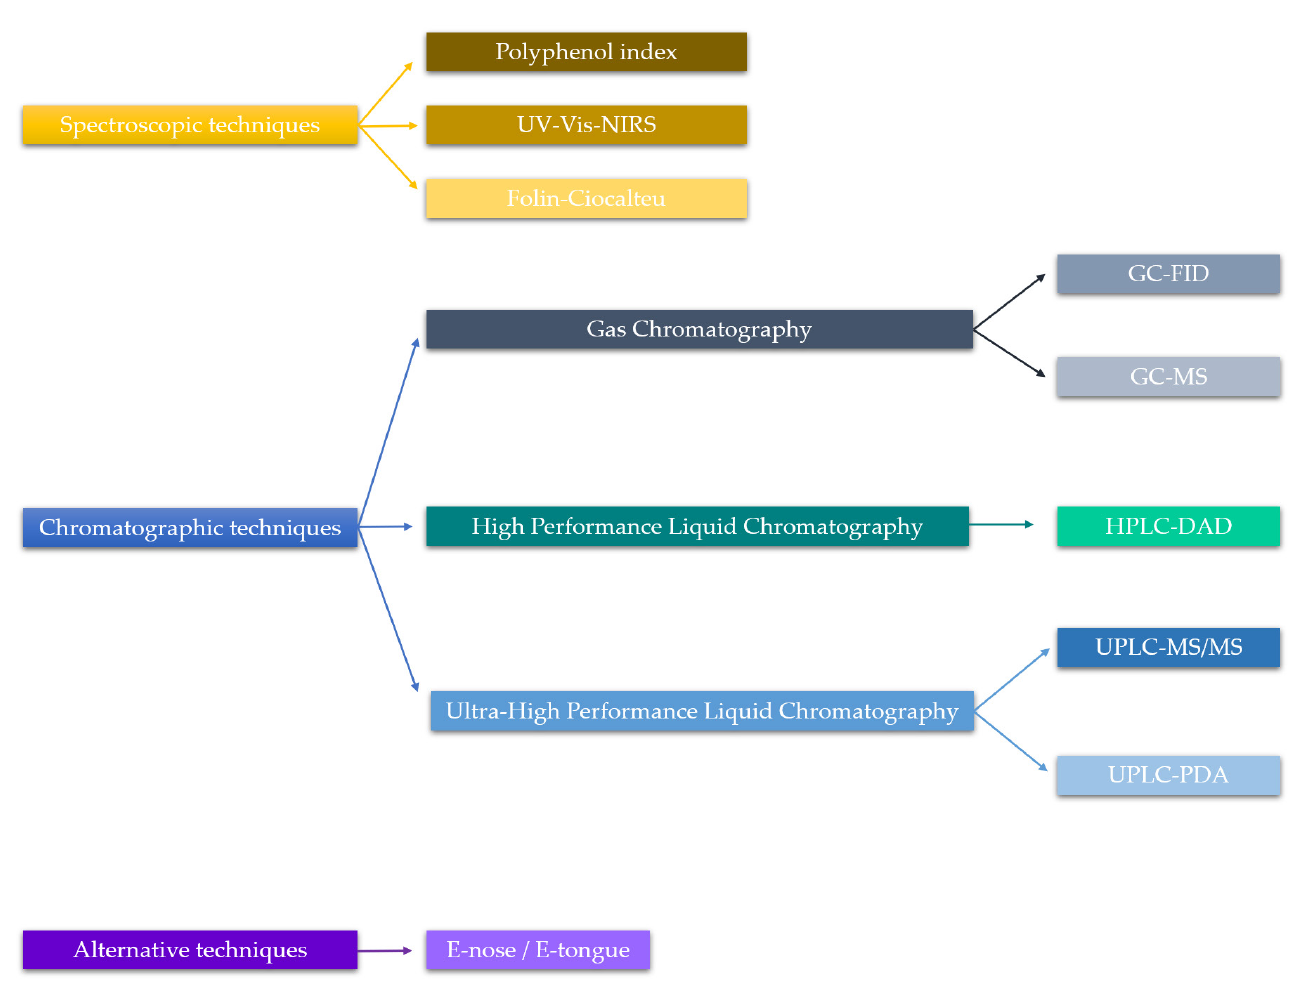
Figure 3. Summary diagram about the analytical techniques studied for phenolic compounds analysis on the grape, must, and wine.